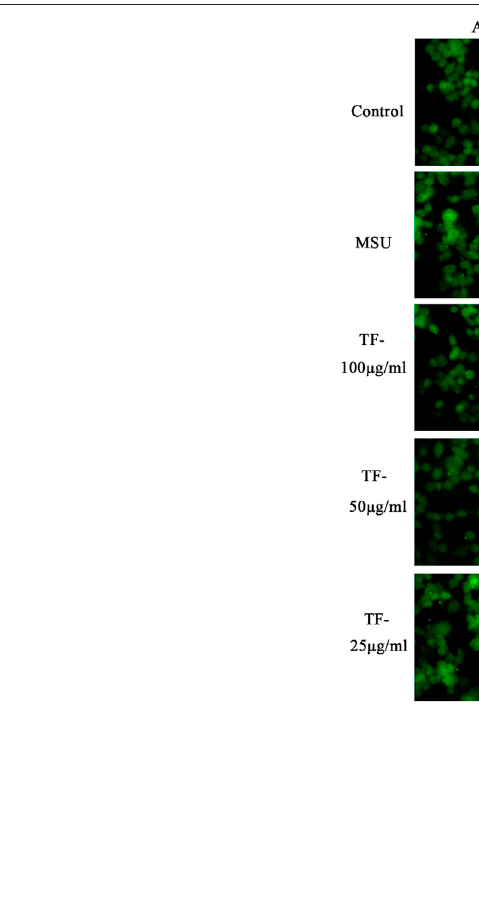
Frontiers in Pharmacology |